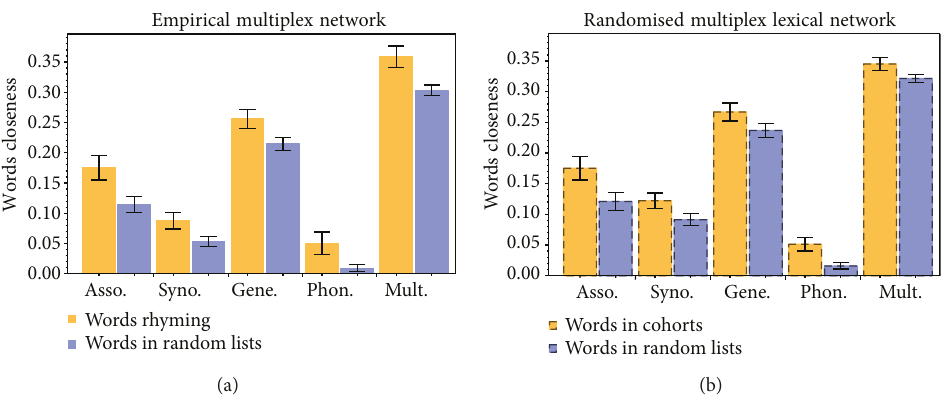
Figure 4: (a) Mean closeness distance of words either in cohorts or in randomised lists in the layers, respectively, made of free associations (Asso.), synonyms (Syno.), generalisations (Gene.), and phonological similarities (Phon.). (b) The same as in (a) but for randomised layers of word-word